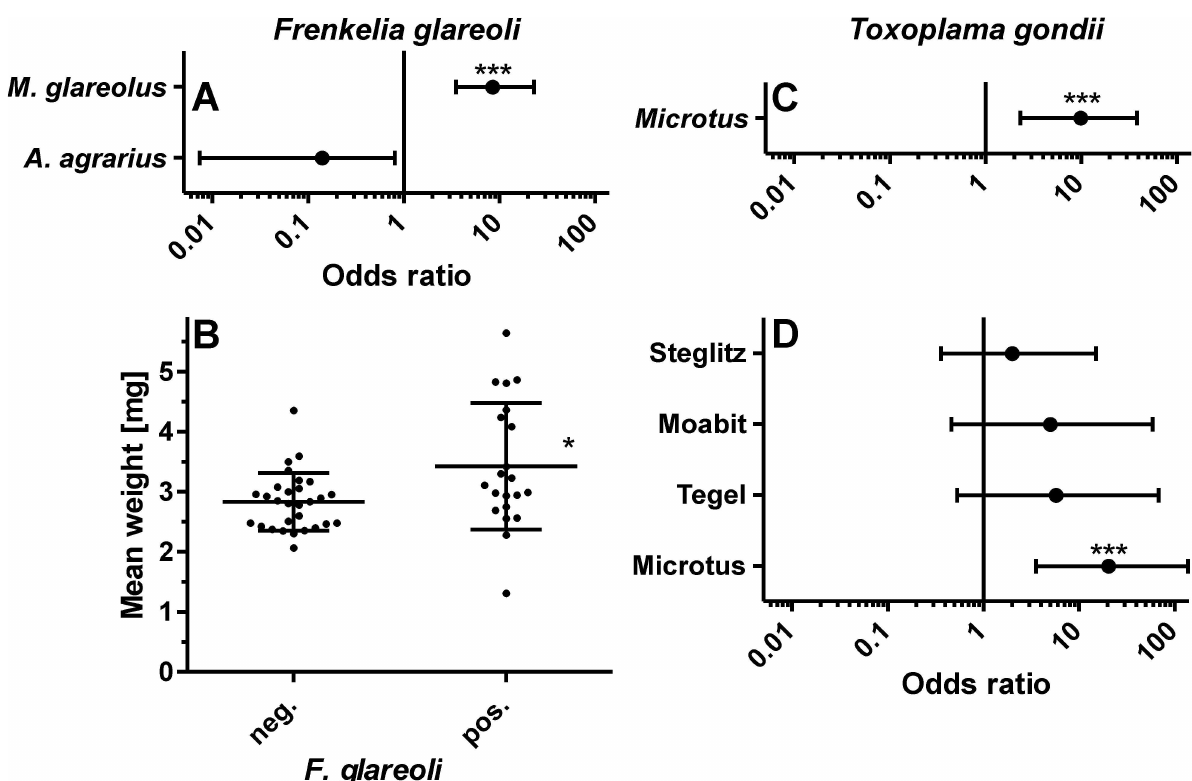
Fig 1. Statistical analysis of parameters affecting the probability to detect DNA from Coccidia. (A) Odds ratios with 95% confidence intervals are shown for variablesdeterminingthe risk for detectionof Frenkeliaglareoli in Myodes glareolus and Apodemusagrarius comparedto Apodemusflavicollis .A model considering only the rodent species as explanatory variablesis presented. Odds ratios for Apodemussylvaticus , Microtus agrestis and Microtus arvalis were 9.3 × 10 − 8 and were omitted from the figure due to the fact that the parasite was not found in any of these animalsand the resultingvery wide confidenceintervals. (B) Distributionof dry eye lens weights, as an indirect indicatorfor age, in M . glareolus with and without F . glareoli infection. Only animalstrapped in 2011 were consideredsince eye lens weights were not determinedin 2010. Individualpoints representingmeans of two eye lenses are shown together with means ± SD for all animals in the group. * , p < 0.05 in a Mann-Whitney U test. (C, D). Odds ratios with 95% confidenceintervals for the probabilityto detect Toxoplasmagondii DNA in the brain by PCR are illustrated. The model in (C) considered only the rodent genus, the model in (D) genus and study location. Myodes is not shown since T . gondii was not found in these rodents. The odds ratios for Myodes spp. was 7.0 × 10 − 8 and the 95% confidenceintervalwas very wide. Referencecategorieswere Apodemus for genusand Gatow for study location.All odds ratios and significancelevels were calculatedby logistic regressionfollowedby t test to determine the significanceof the effects. *** , p <